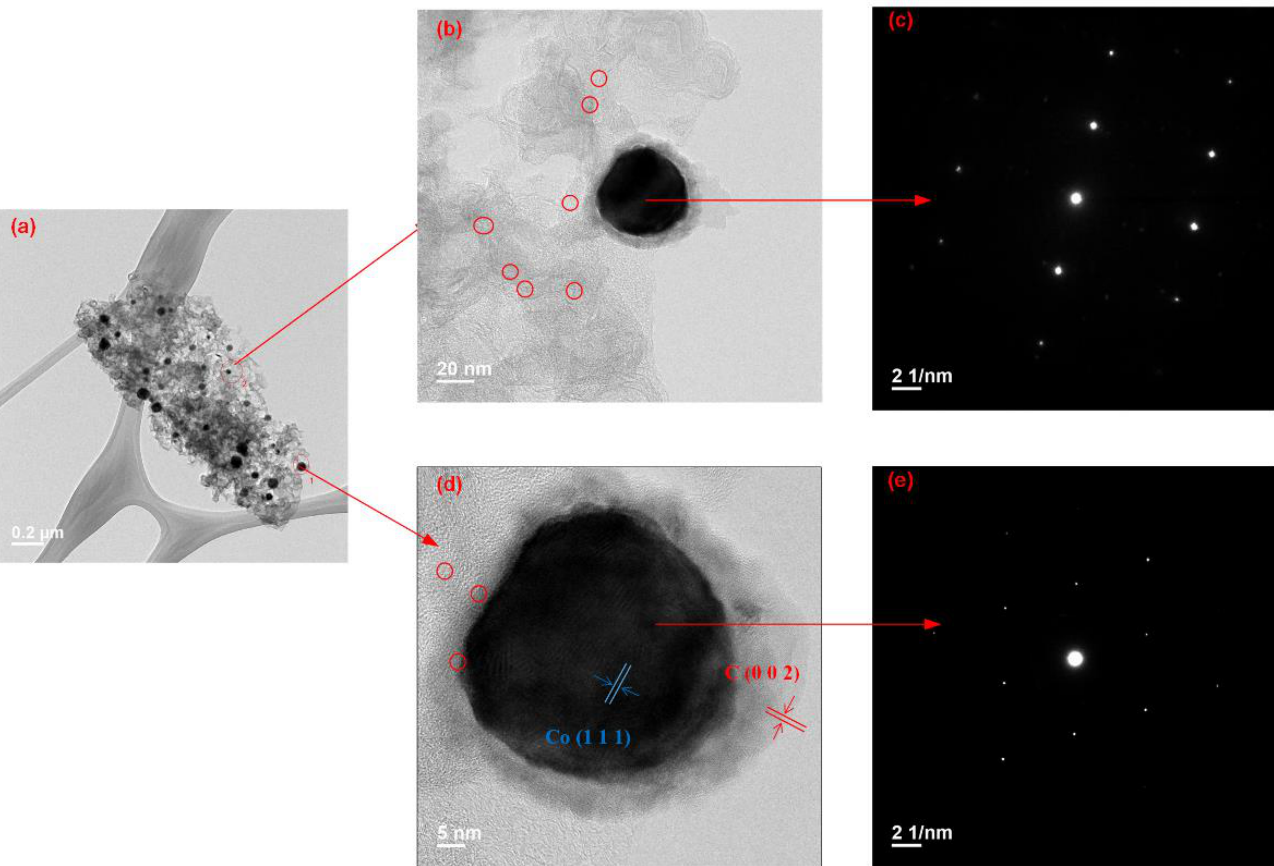
Figure 5. HRTEM micrographs and electron diffraction patterns of CoNC-1000A-900. ( a , b , d ): images of CoNC-1000A-900. ( c , e ) electron diffraction patterns of CoNC-1000A-900.